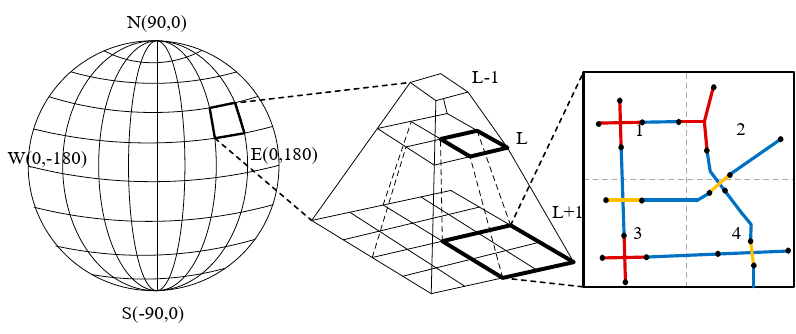
Figure 3. Hierarchical block data structure.